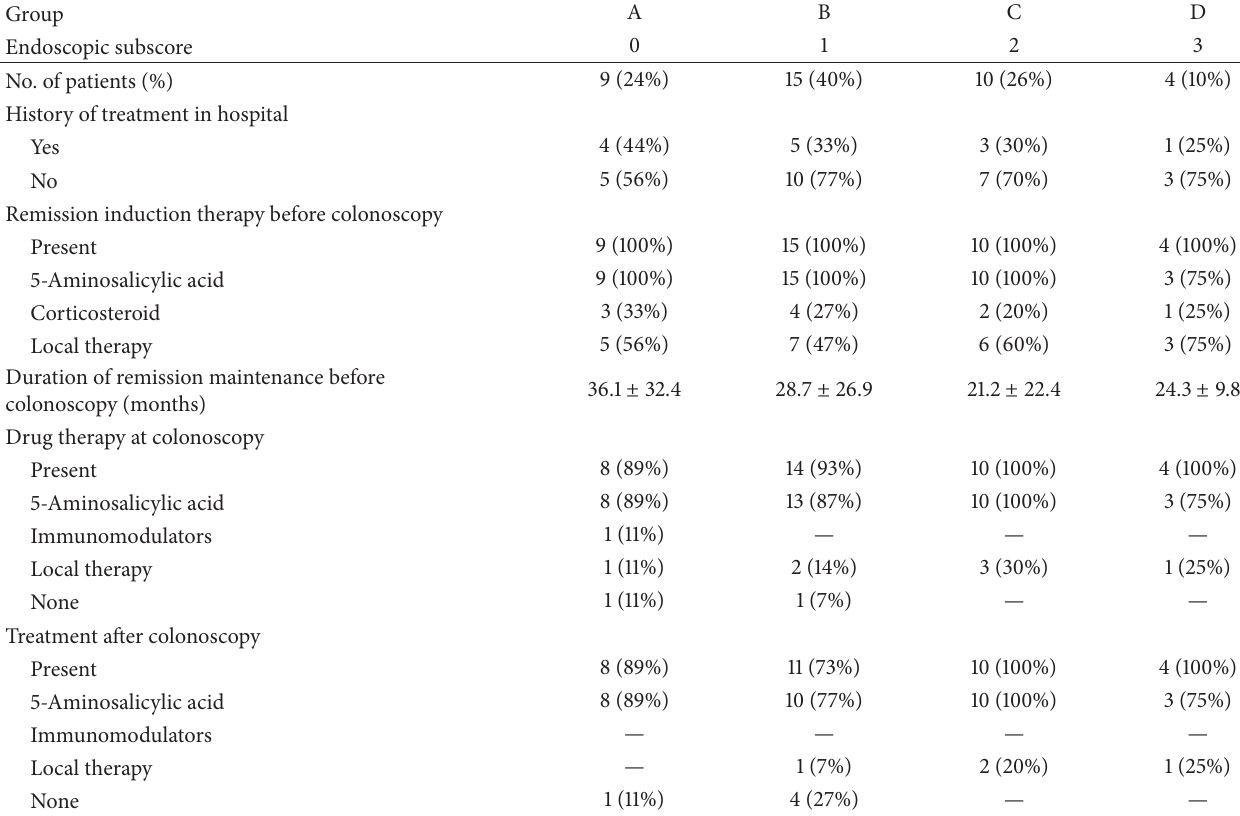
Table 2: Treatment regimens according to the Mayo endoscopic